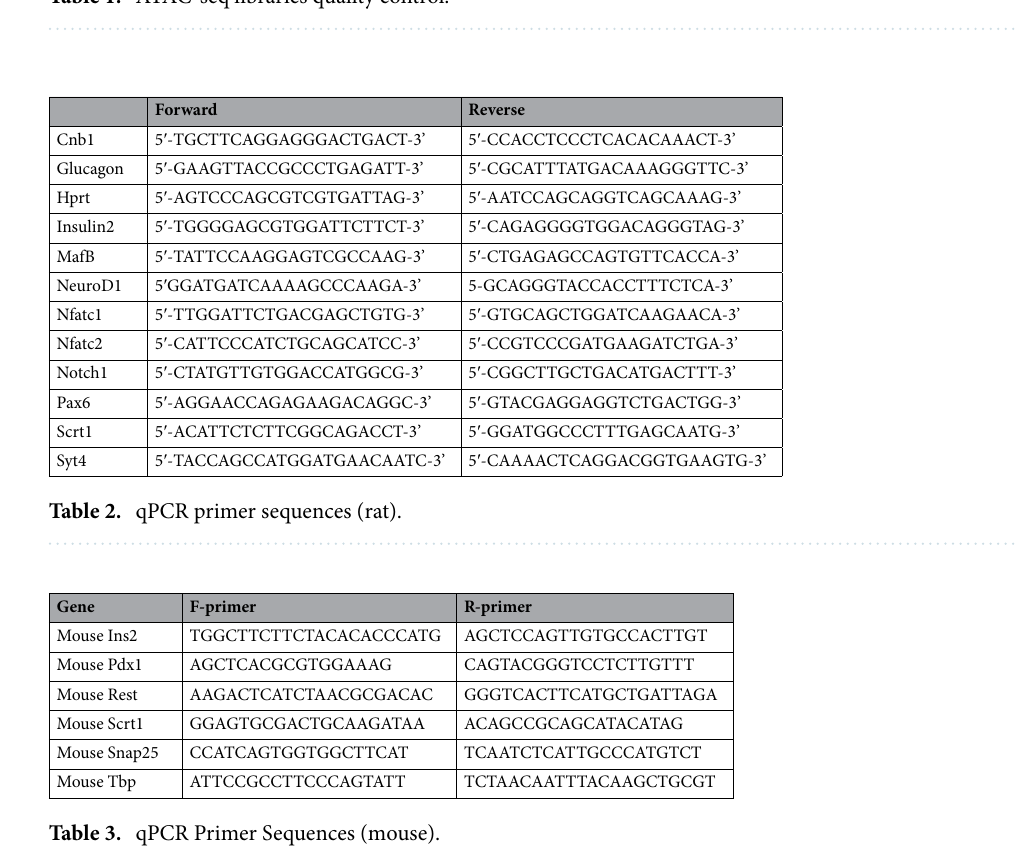
Table 1. ATAC-seq libraries quality control.